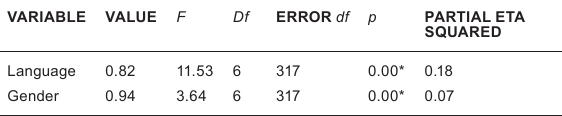
table 7 MANOVAs of emotional intelligence of language and gender